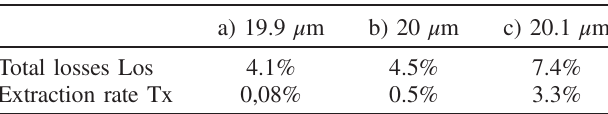
TABLE III. Total losses L wavelength corresponding to the profiles of Fig.